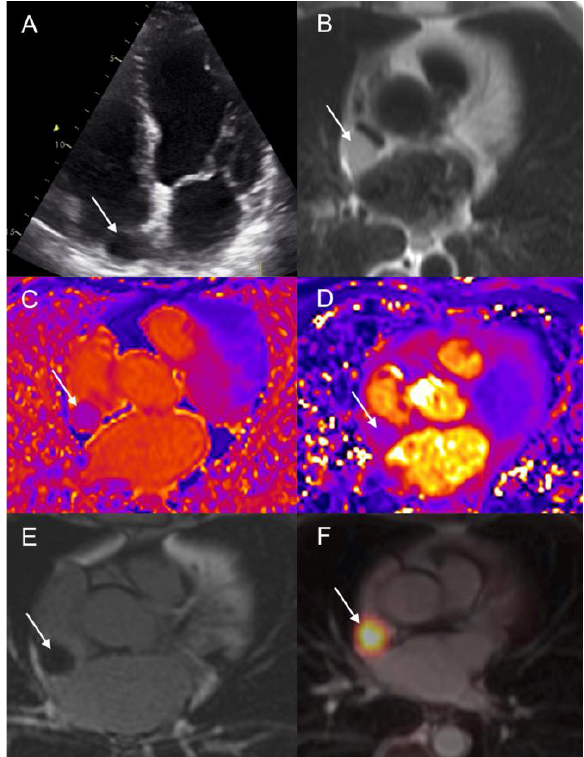
Figure 8. Patient 4. TTE (4-chamber view) showing hypoechogeneous lesion on the right side of inter-atrial septum (( A ) arrow). Lesion showed intermediate signal intensity on T1-weighted dark-blood CMR images (( B ) arrow). T1- ( C ) and T2-mapping ( D ) analysis revealed short T1 and moderately increased T2 values ( D ). CM showed a slight peripheral enhancement on delayed post-contrast inversion recovery sequences ( E ). Fused 68 Ga-DOTATOC PET/CMR images (axial slice) ( F ).